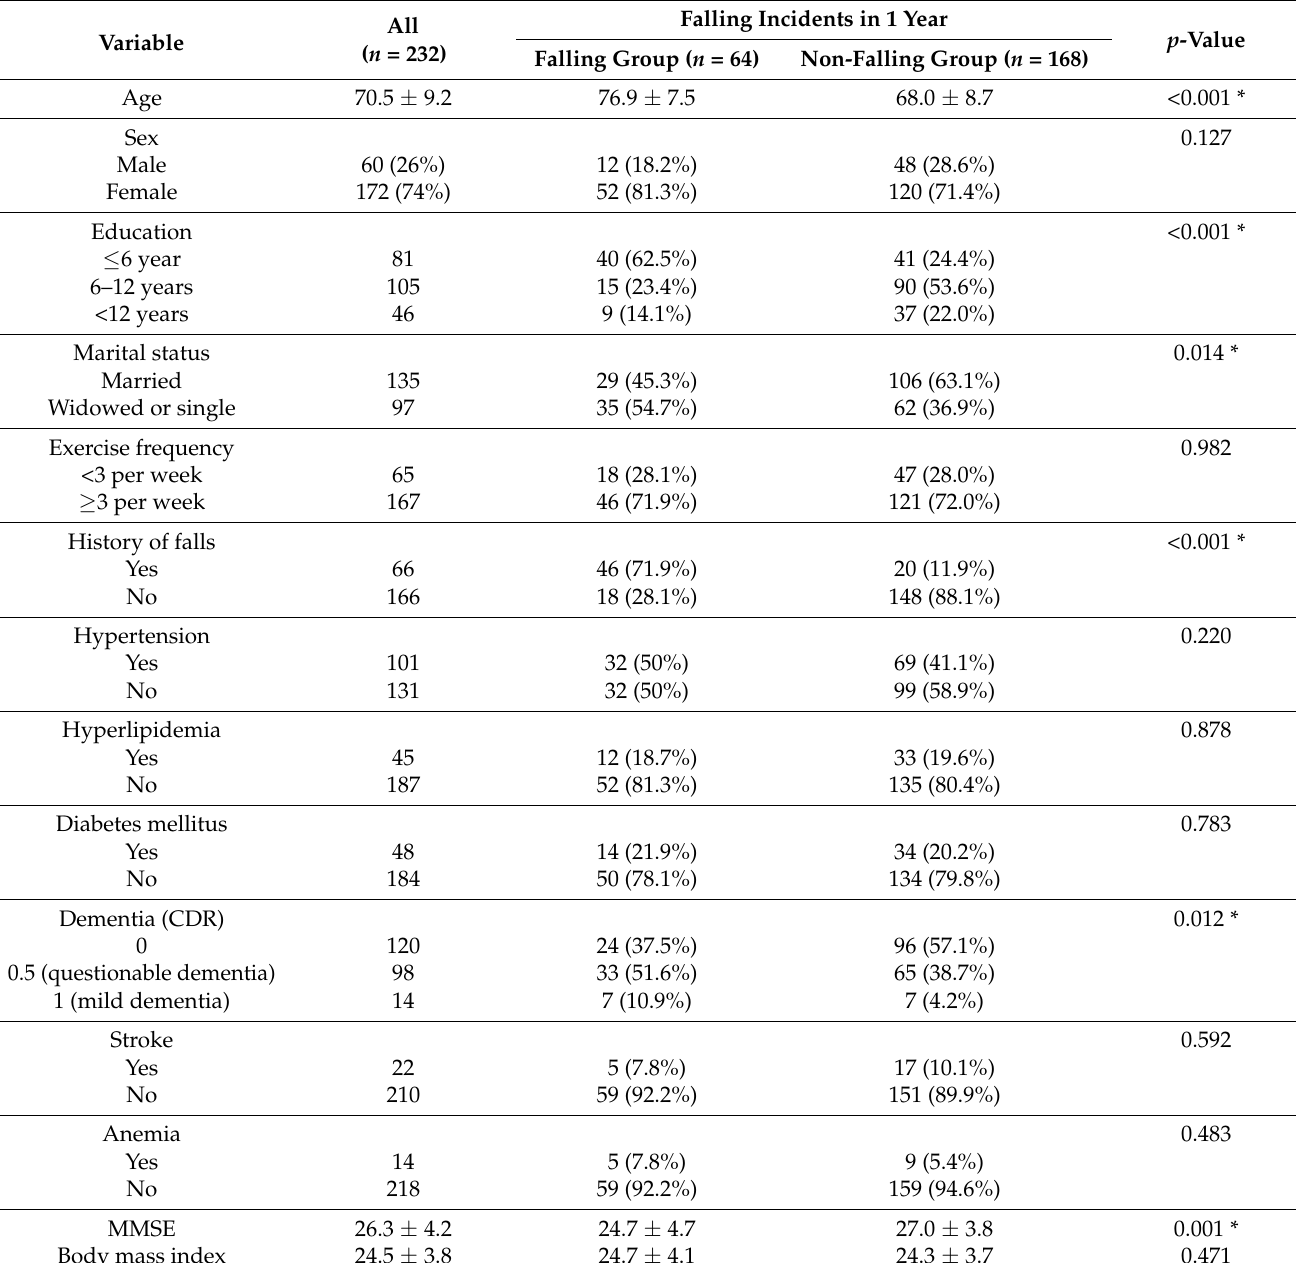
Table 1. General characteristics of community-dwelling elderly